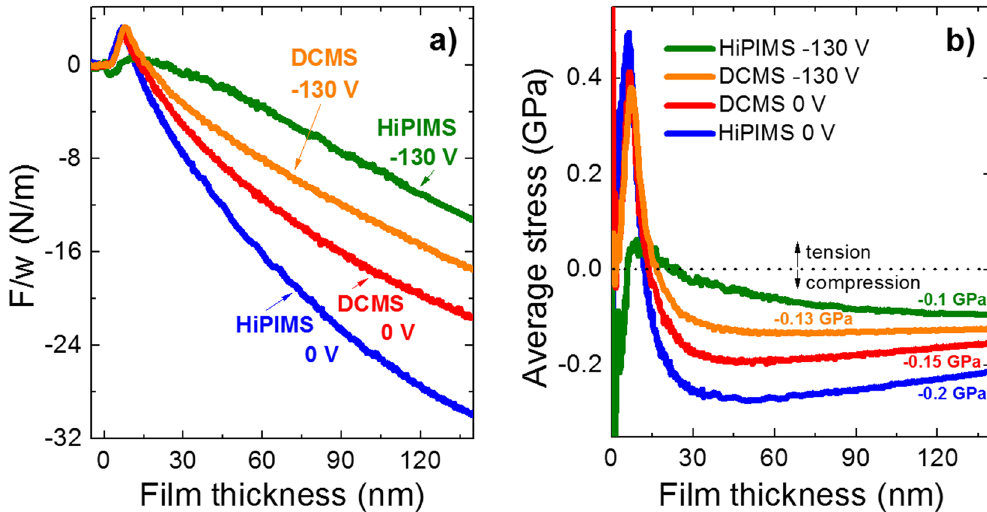
Figure 3. In situ intrinsic stress measurements during thin film growth. Evolution of ( a ) the film force per unit width, F/w , and ( b ) average stress, <σ> , as a function of film thickness for grounded (0 V) and − 130 V bias DCMS and HiPIMS Cu